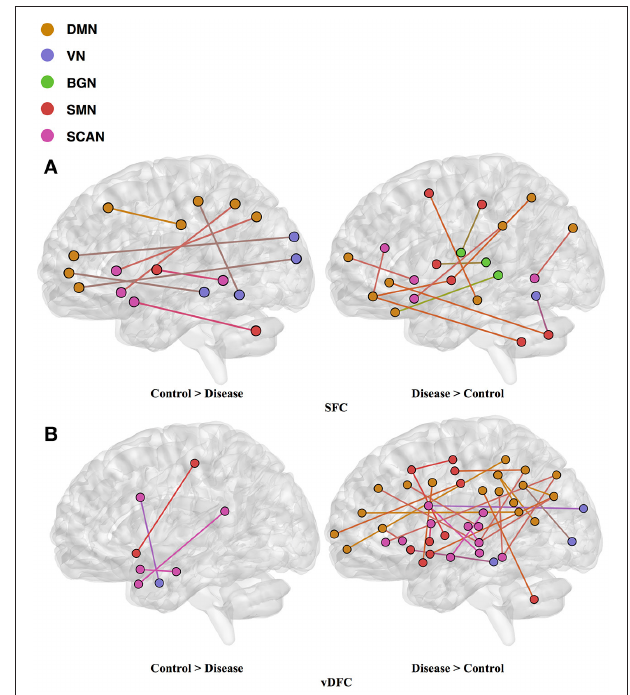
FIGURE 7 | (A) SFC; (B) vDFS features. selected by GA and hierarchical (AD). Selected features were split into two groups, i.e., (1) control > disease (AD, LMCI and EMCI) and (2) disease > control. DMN, Default mode network; VN, Visual network; BGN, Basal ganglia network; SMN, Sensory motor network; SCAN, Semantic cognition and attention network.